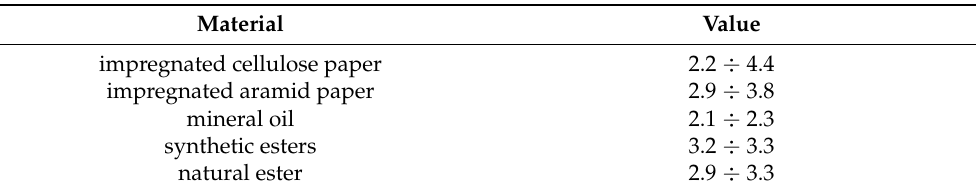
Table 3. Relative electrical permittivity of insulating materials used in power transformer, for T = 25 ◦ C